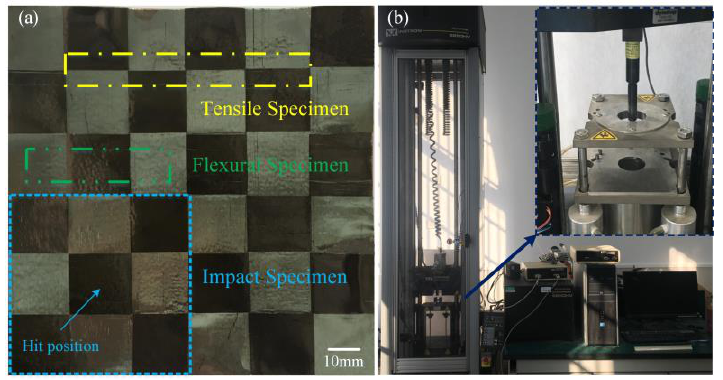
Figure 2. Preparation of specimens and testing apparatus: ( a ) illustration of the sampling position for the tensile, flexural and impact tests; ( b ) the scene photos of a drop-weight impact test.